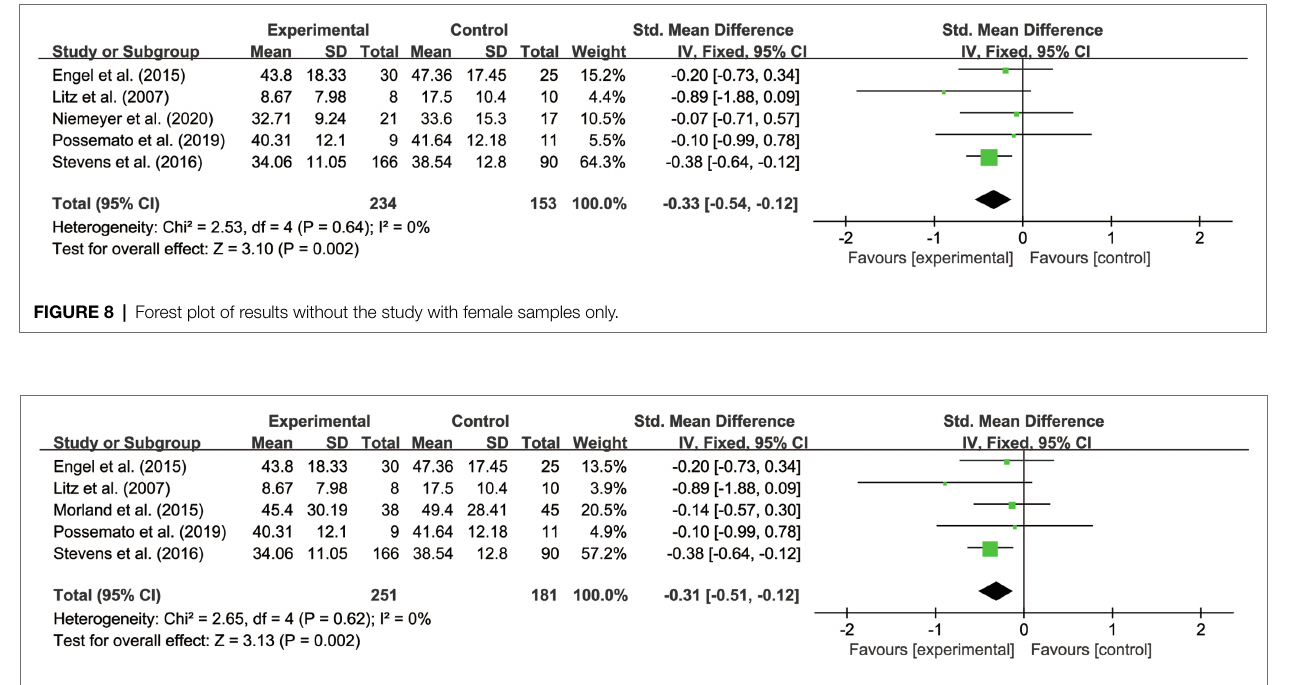
FIGURE 9 | Forest plot of results without the study with male samples and different